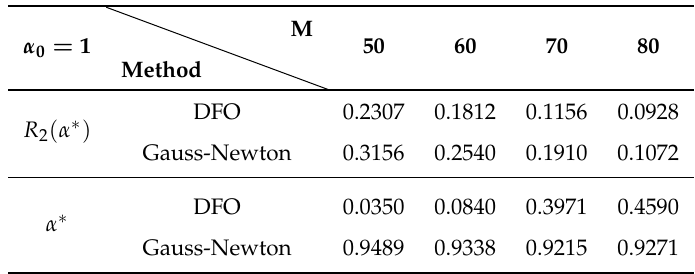
Table 1. The results of the Gauss–Newton method and the DFO method on different M values with α 0 = 1.